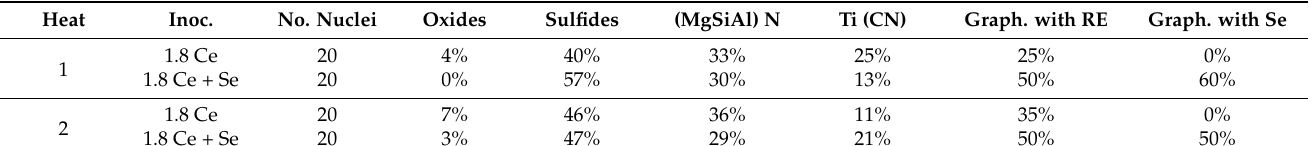
Table 5. Main inclusions detected in the graphite acting as nuclei.